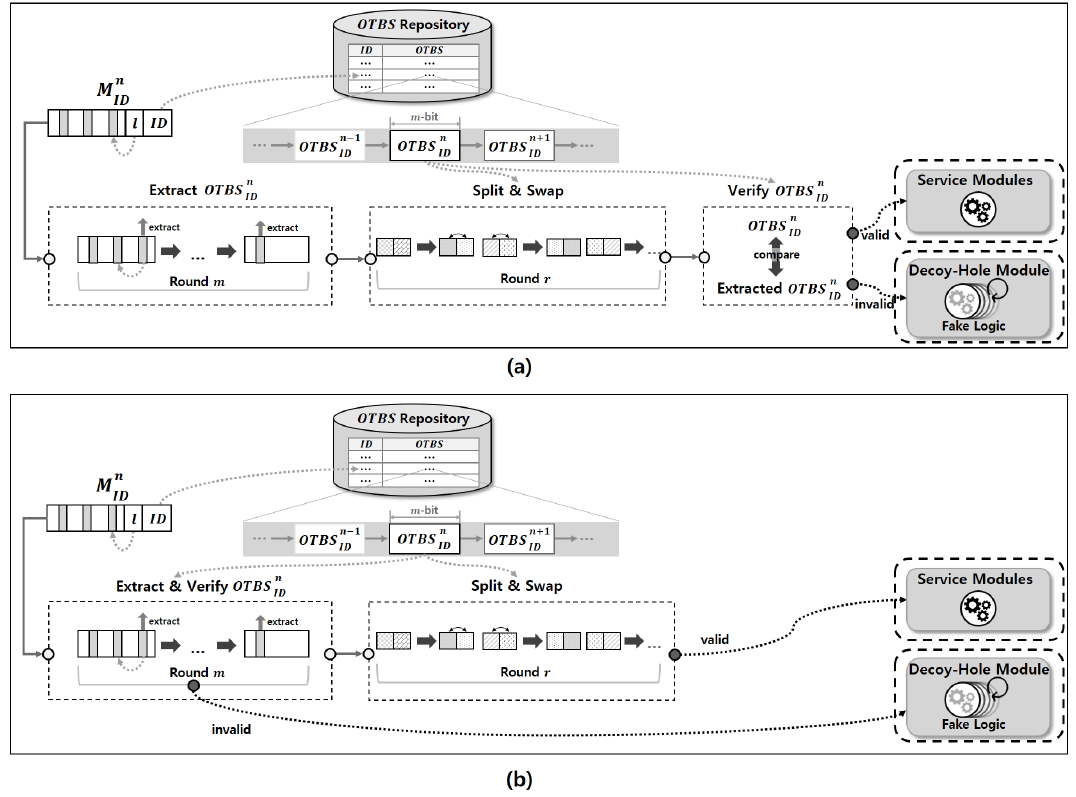
Figure 3. Operation process for message validation and deception: ( a ) native validation scheme; ( b ) validation scheme on the basis of gMTD